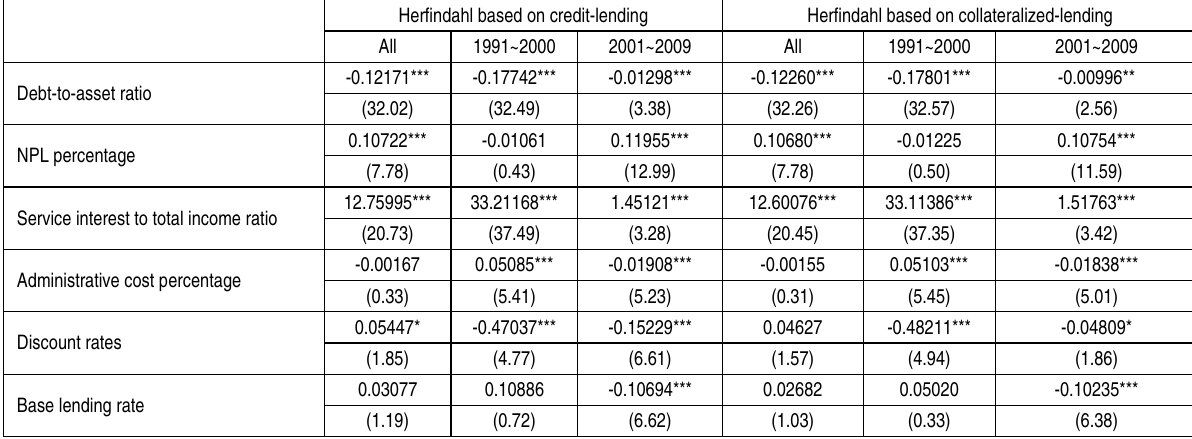
Table 8. Herfindahls based on credit lending and collateralized lending – base